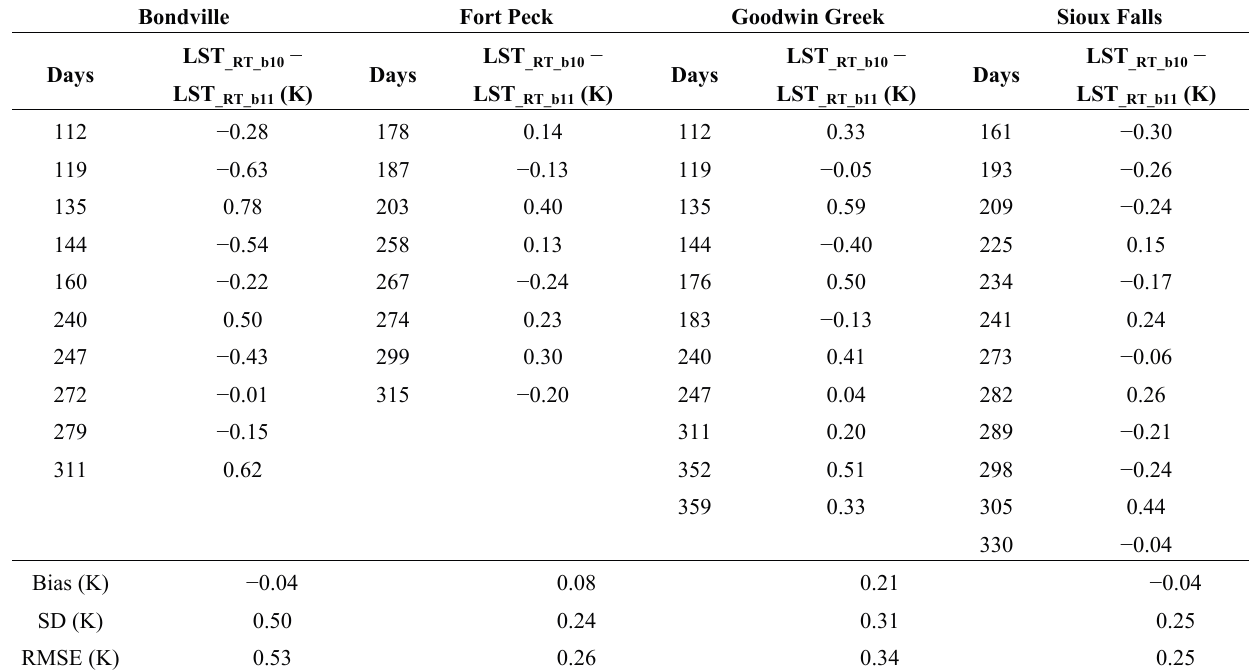
Table 10. Inverted LST (LST difference ( Δ ) between LST